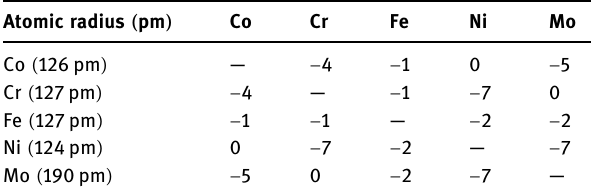
Table 1: Binary mixing enthalpy ( unit: kJ · mol − 1 ) and atomic sizes of di ff erent